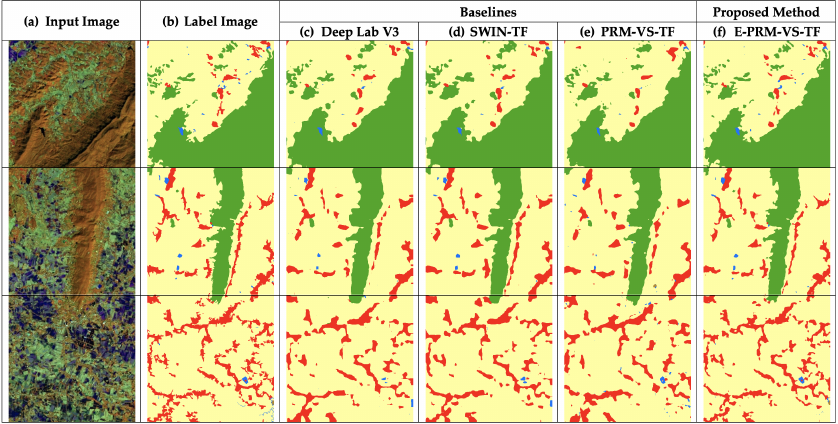
Figure 7. The performance of the forest (green) prediction reveals no significant difference between any models.